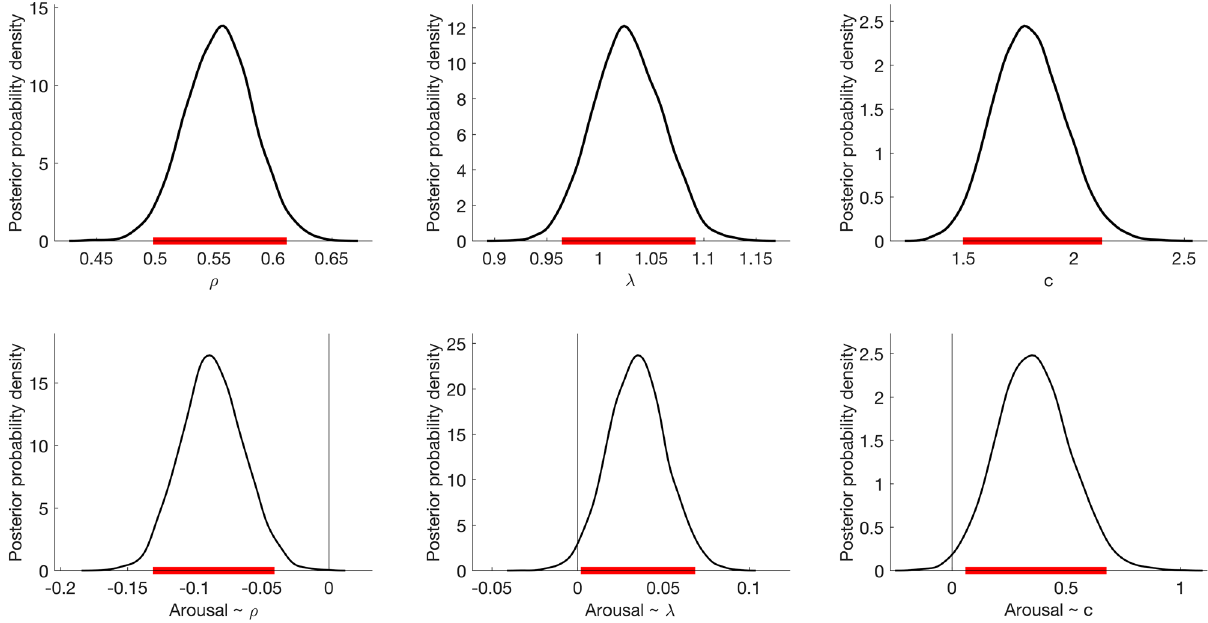
Figure 3. The posterior distributions on model parameter estimates showing the group level means and trial-to-trial influences of arousal on decision parameters. The upper panel shows the posterior distributions and the 95% HDIs for group level parameters (marked ranges under the distributions). The lower panel shows the posterior distribution of the regression coefficients. The peak value of each distribution represents the best estimate, while the width represents the uncertainty of the